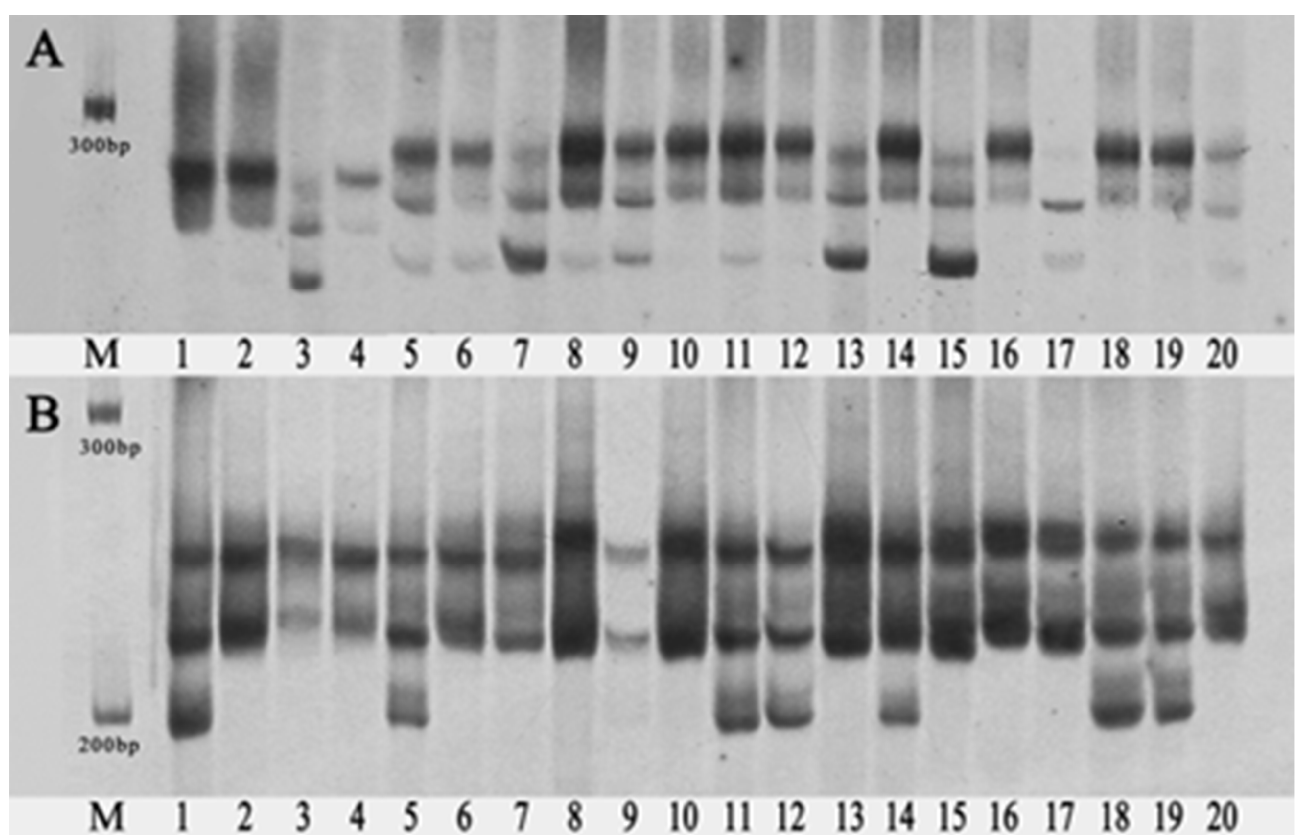
Figure 5. SSR profiles of the wild plant and 19 randomly selected plants regenerated from immature seeds of wild A. trifoliate . ( A ) Banding patterns of SSR marker MT15. ( B ) Banding patterns of SSR marker MT28. M: 1000 bp DNA marker; 1: the wild plant; 2–20: the 19 randomly selected plants, including two Type Ι plants (lanes 6–7) and three Type ΙΙ plants (lanes 18–20).